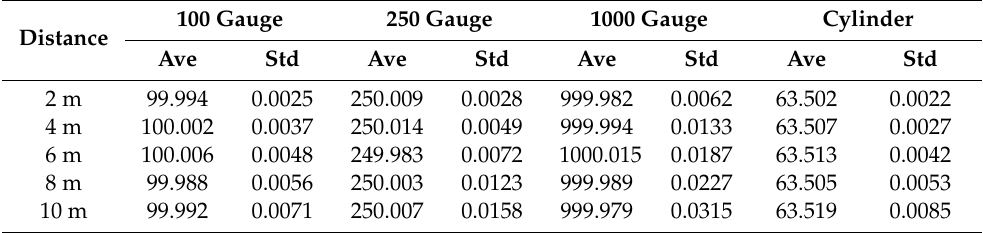
Table 5. The results of measurement experiment of LPCMS. The meanings of the abbreviations Ave and Std are the same as in Table 4 (mm).